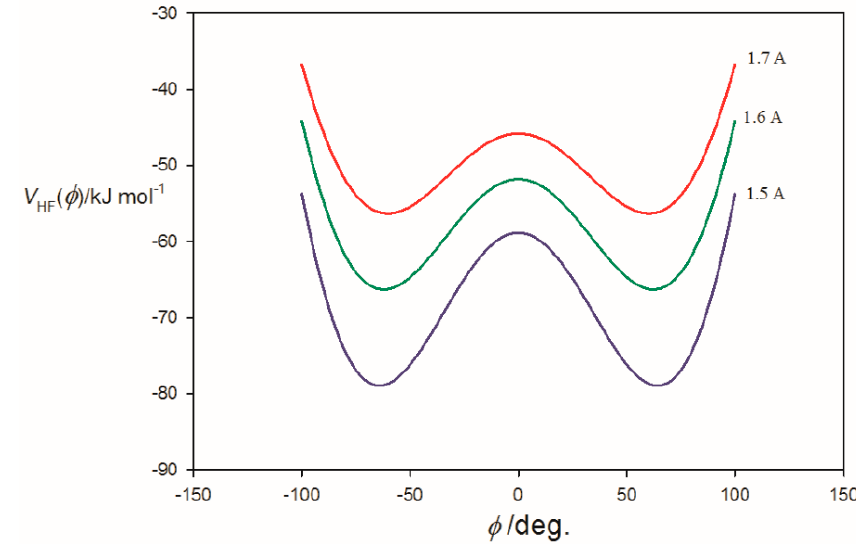
Figure 11. The electrostatic potential energy V HF ( φ ) of HF treated as a simple extended electric dipole as a function of angle φ at three distances of the H atom of HF from the O atom of oxetane.